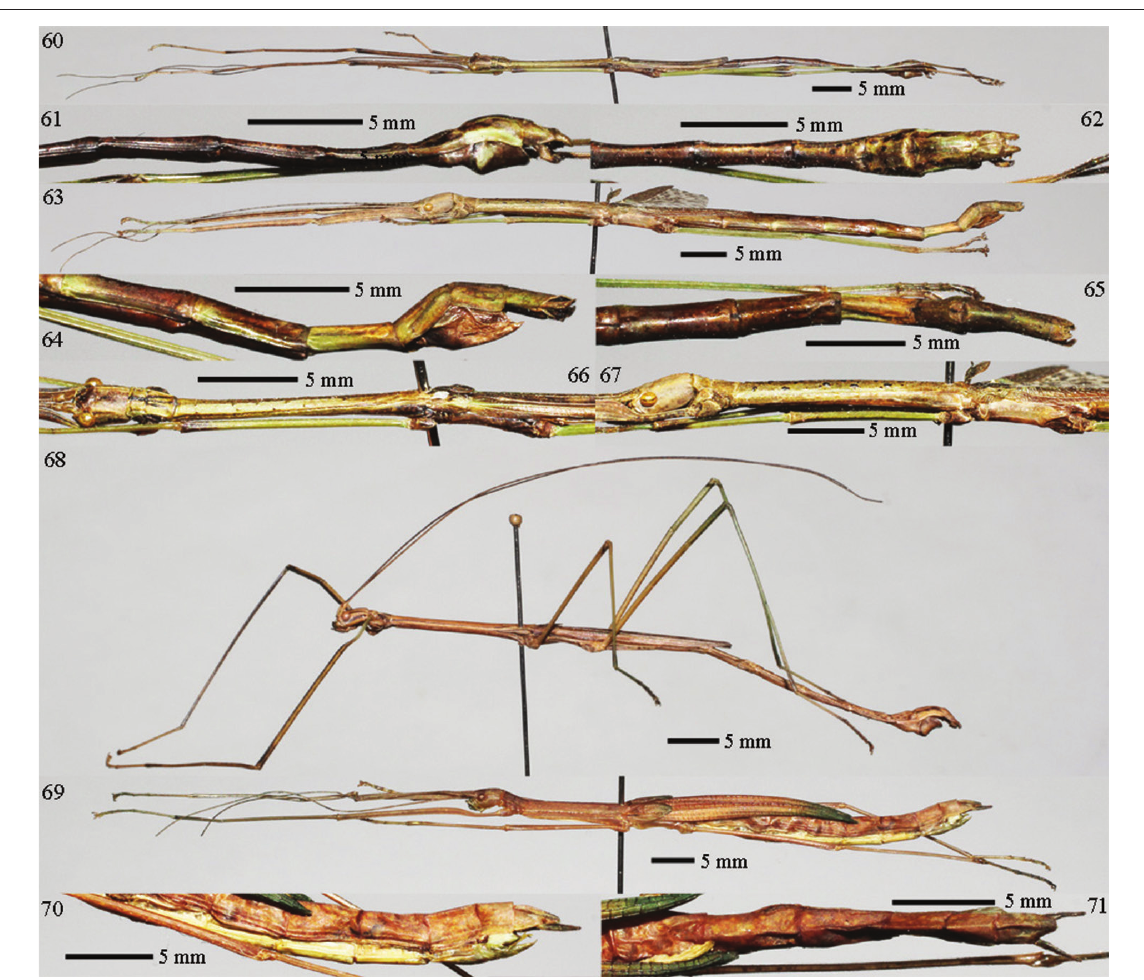
Figs 60–71. Parasinophasma spp. 60. P . luchunense luchunense sp. n. and subsp. n.: ♂ , habitus; 61. P . luchunense luchunense sp. n. and subsp. n.: ♂ , apex of abdomen, lateral view; 62. P . luchunense luchunense sp. n. and subsp. n.: ♂ , apex of abdomen, dorsal view;